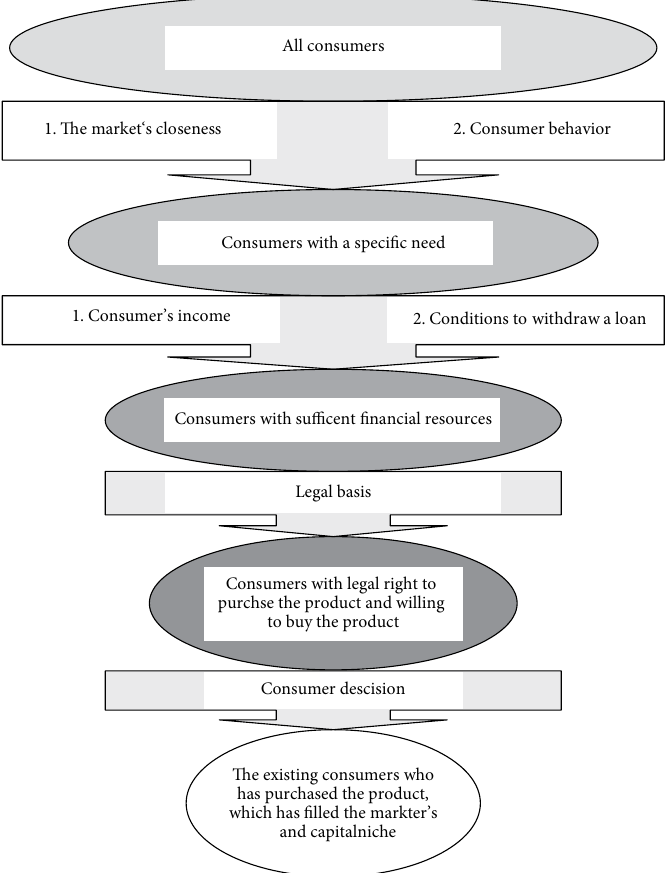
Fig. 7. Factors influencing market and capital niche